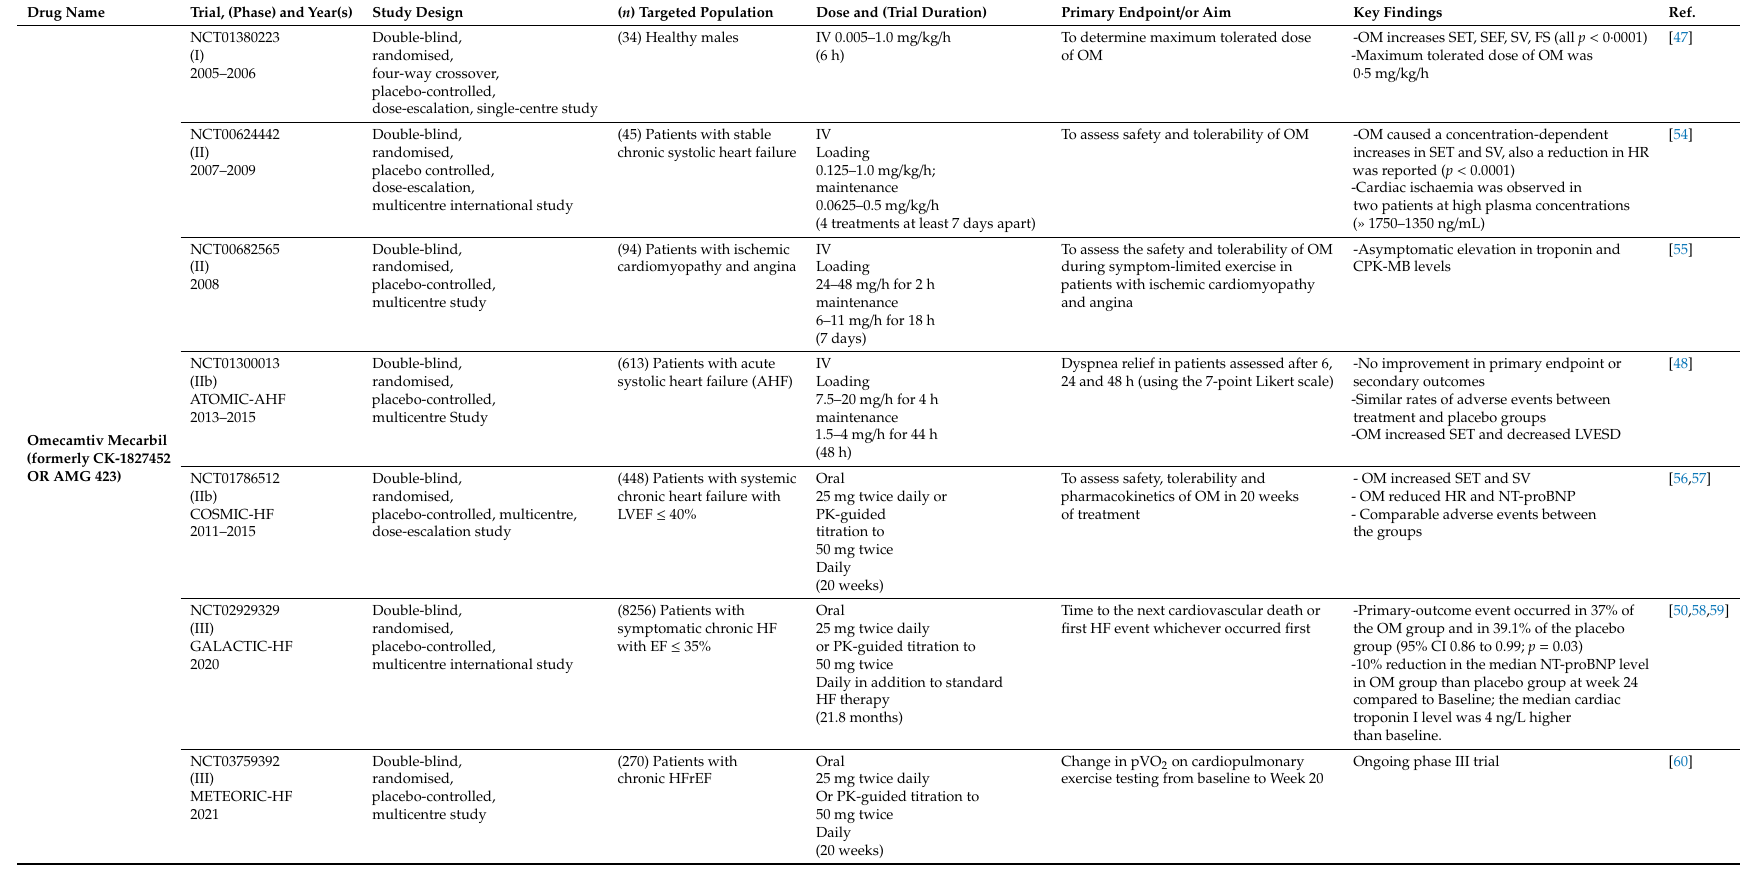
Table 2. Overview of all reported clinical trials on cardiac myosin